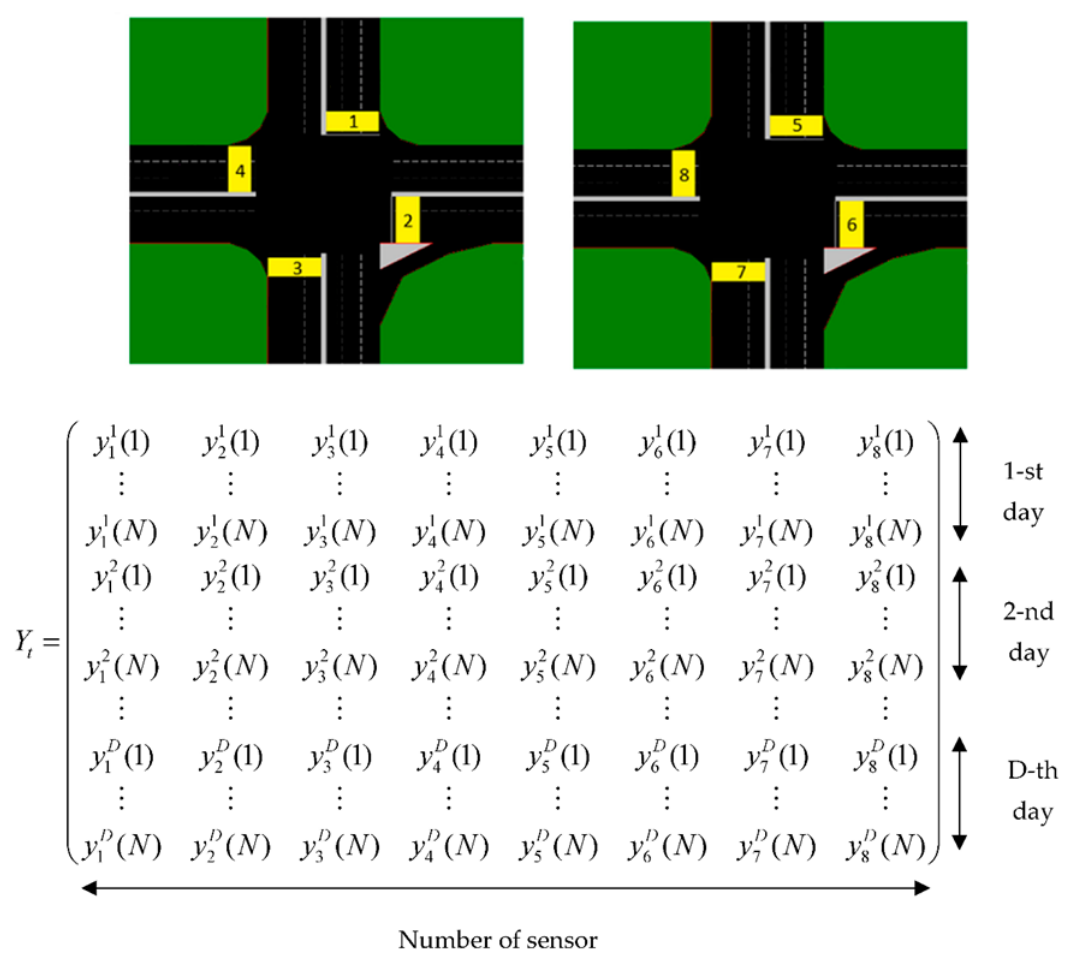
Figure 1. An example of construction of spatiotemporal data matrix (Equation (4)). The numbered yellow boxes on the top figure represent each vehicle detector.